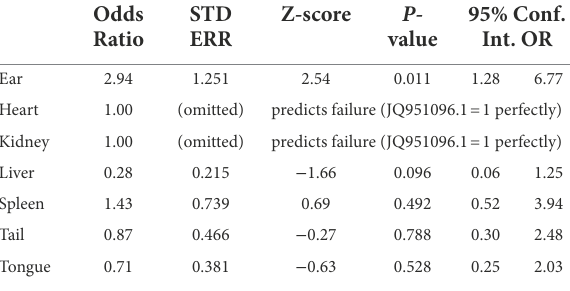
TABLE 5 Statistical comparison of Borreliella type JQ951096.1 using logistic regression. Odds STD Ratio